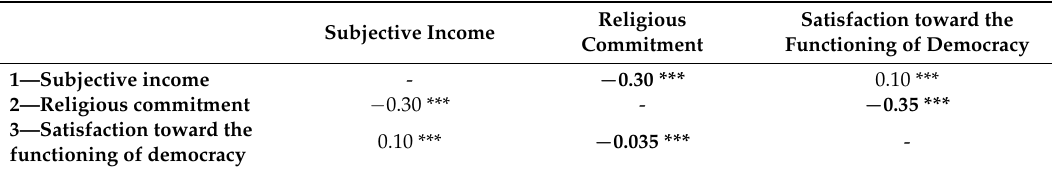
Table 1. Matrix of correlations between the variables that make up the